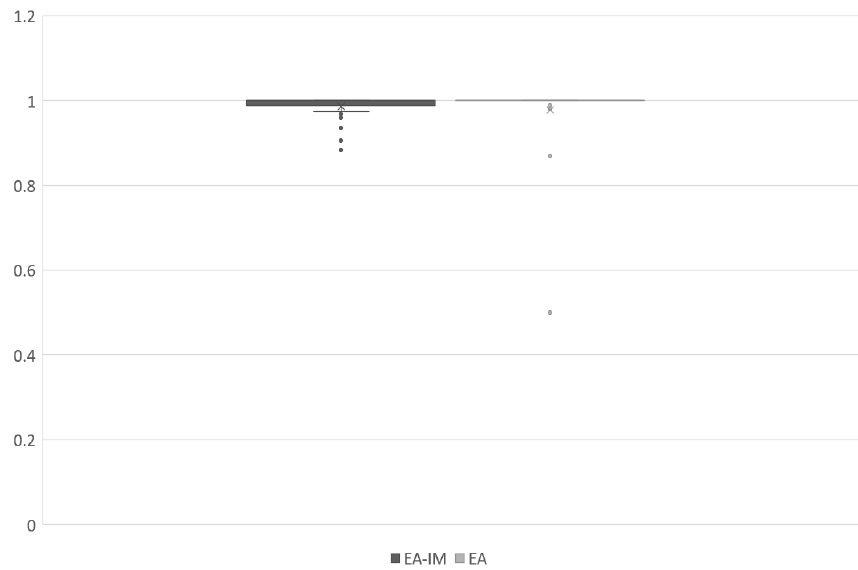
Figure 9. Comparison of EA-IM and EA on the Box-and-whisker Plot in terms of precision.